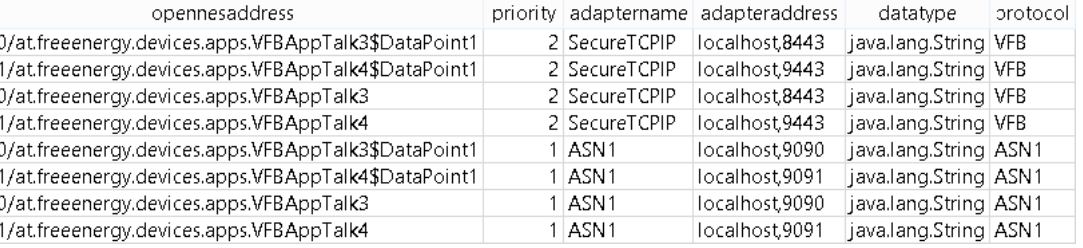
Figure 19. Address mapping on IED1 during Test (c).